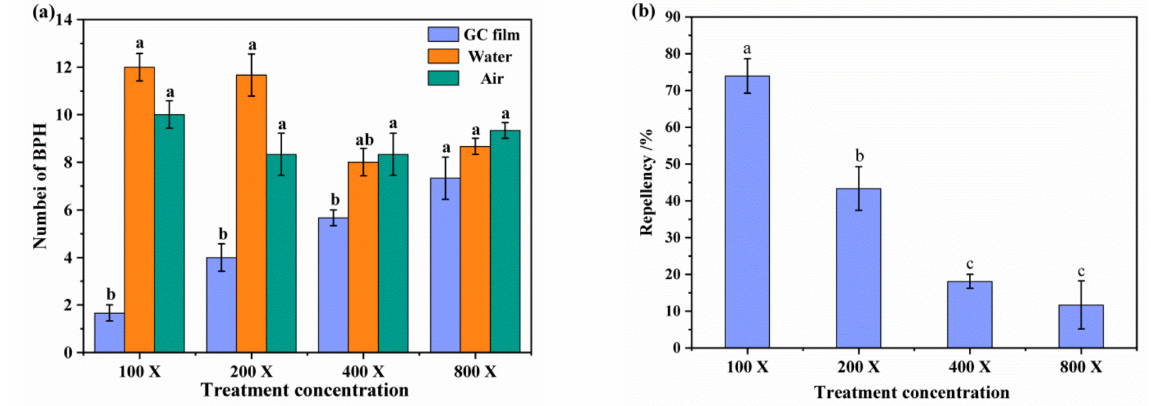
Figure 2. The olfactory reaction and repellent effect of GC film on BPHs after treatment for 4 h. ( a ) The number of BPHs in GC film (blue), water (brown), and air (green) flavor source treatment. ( b ) The repellency in different GC film treatments of 100 dilution multiple (100 × ), 200 dilution multiple (200 × ), 400 dilution multiple (400 × ), and 800 dilution multiple (800 × ). Water was used as control. The data are expressed as mean ± SD from three